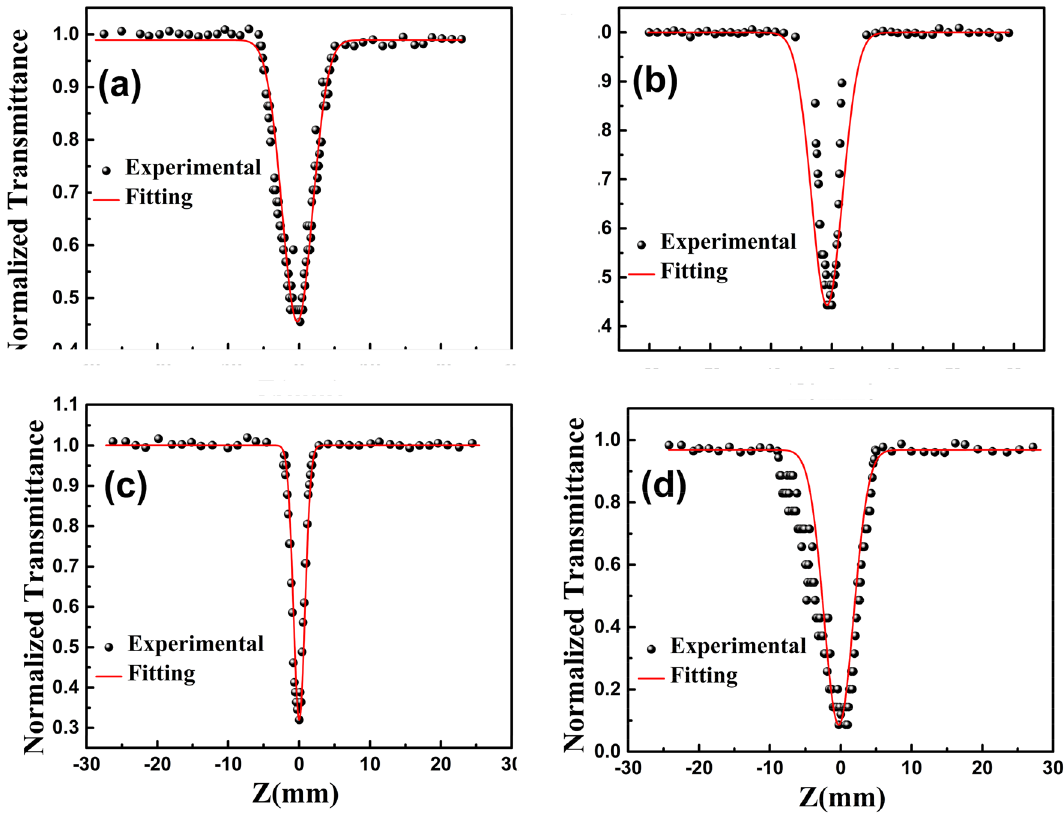
Figure 5. Open aperture measurements (at 532 nm) of ( a ) GO, ( b ) RGO, ( c ) GO-ZnO, and ( d ) RGO-ZnO at excitation intensity of 532 nm. Symbols represent experimental data and solid lines represent theoretical